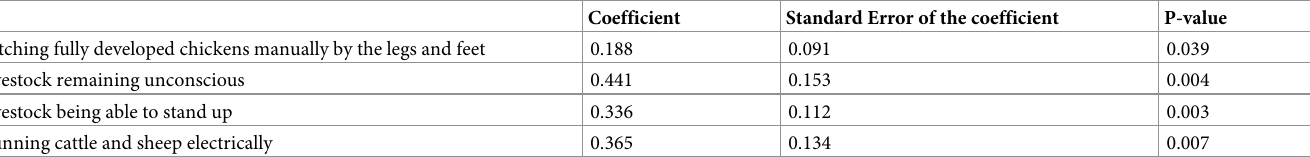
Table 4. Significant (P < 0.05) effects of the duration of involvement of respondents, who were stakeholders in the animal transportation and slaughter sectors, with the industry on the mean utility values of issues, which measure the perceived importance of different issues for animal welfare, when the relationship is exam- ined by linear regression in a general linear model. The relationship is reported as a regression coefficient, SE coefficient and probability (P) value of the regression being significant.